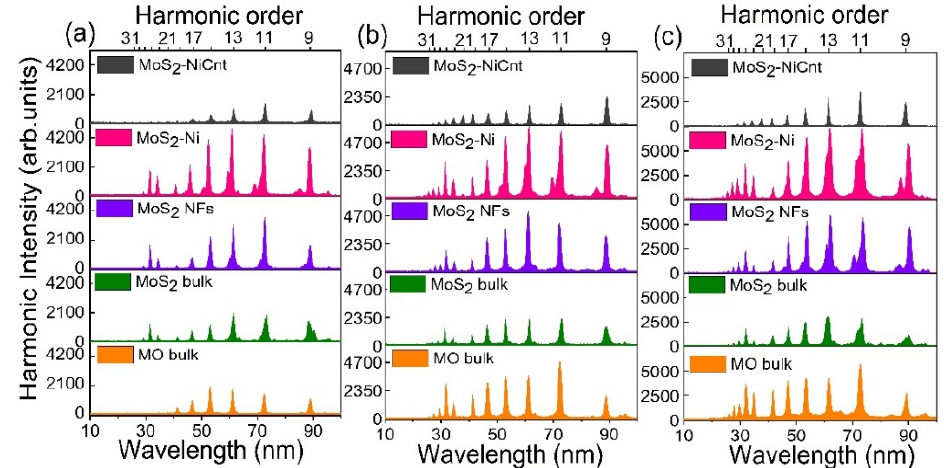
Figure 5. Harmonic spectra from Mo-contained plasmas at different intensities of picosecond HPs and femtosecond DPs. ( a ) 2.1 × 10 9 W/cm 2 and 1.3 × 10 14 W/cm 2 . ( b ) 3.4 × 10 9 W/cm 2 and 2.5 × 10 14 W/cm 2 . ( c ) 5.4 × 10 9 W/cm 2 and 3.4 × 10 14 W/cm 2 .